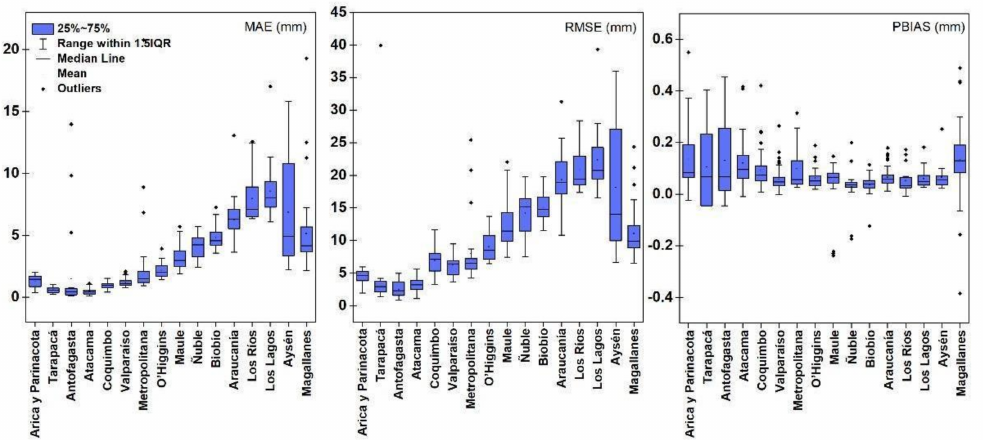
Figure 4. Boxplot of gauge-IMERG Early product errors. 25% and 75% represent the distribution that has an index between the 25th percentile (P25) and 75th percentile (P75), the horizontal line inside the box shows the median, the mean value is included with a black circle, and the so-called “whiskers” mark the maximum and minimum values that are not outside the typical range of the distribution. Outliers are shown with a black